Question: Express in one sentence what the figure is showing.
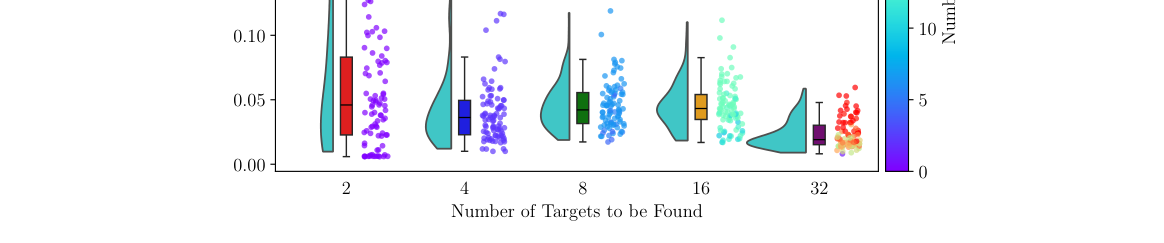
Answer: Normalised time taken in simulation (A-C) and the amount of explored area (D-F) with a varying number of guides in a hierarchical approach for Urban, Maze, and Forest environments with a single target. Average time to find the targets when changing the number of targets (G) in the 60 X 60 urban environment.